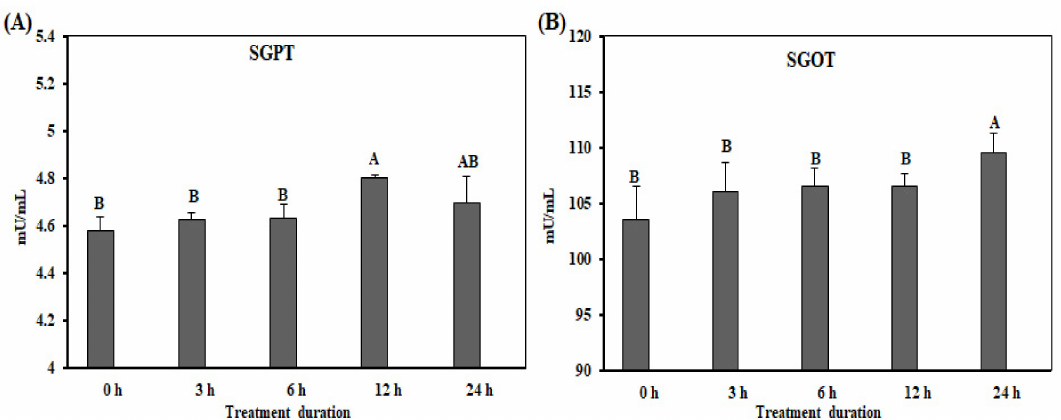
Figure 7. E ff ect of acute heat stress on the levels of serum glutamate pyruvate transaminase (SGPT; ( A )) and serum glutamate oxaloacetate transaminase (SGOT; ( B )) in chickens ( n = 8). A,B SGPT and SGOT in the columns with the di ff erent superscript letters di ff er significantly ( p < 0.05) among the di ff erent heat exposure